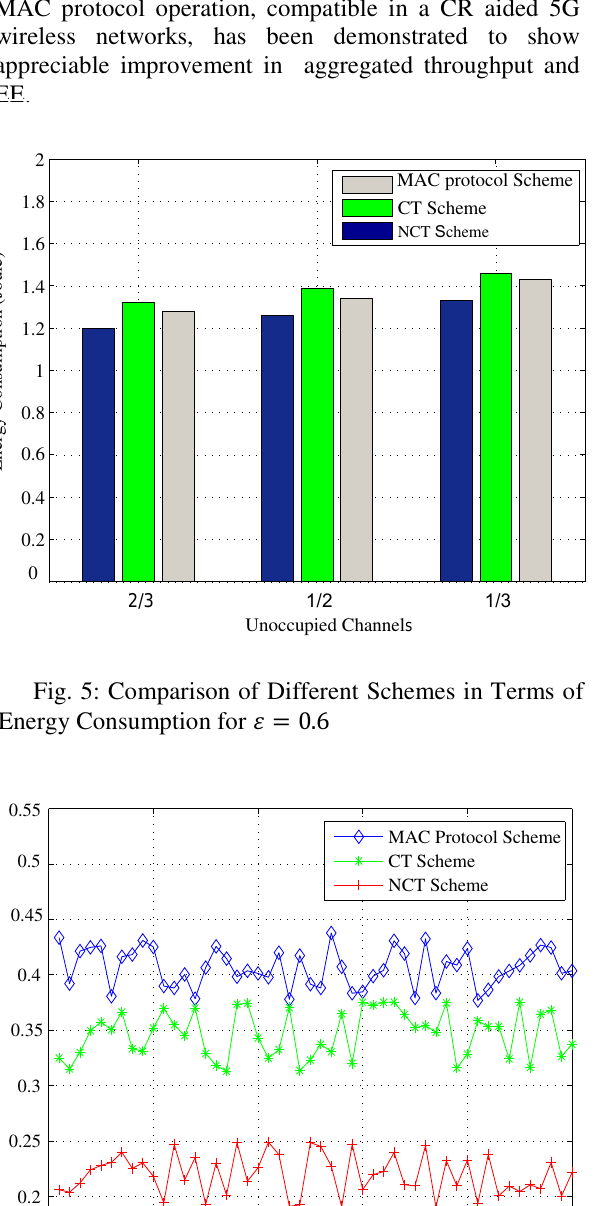
MAC protocol Scheme